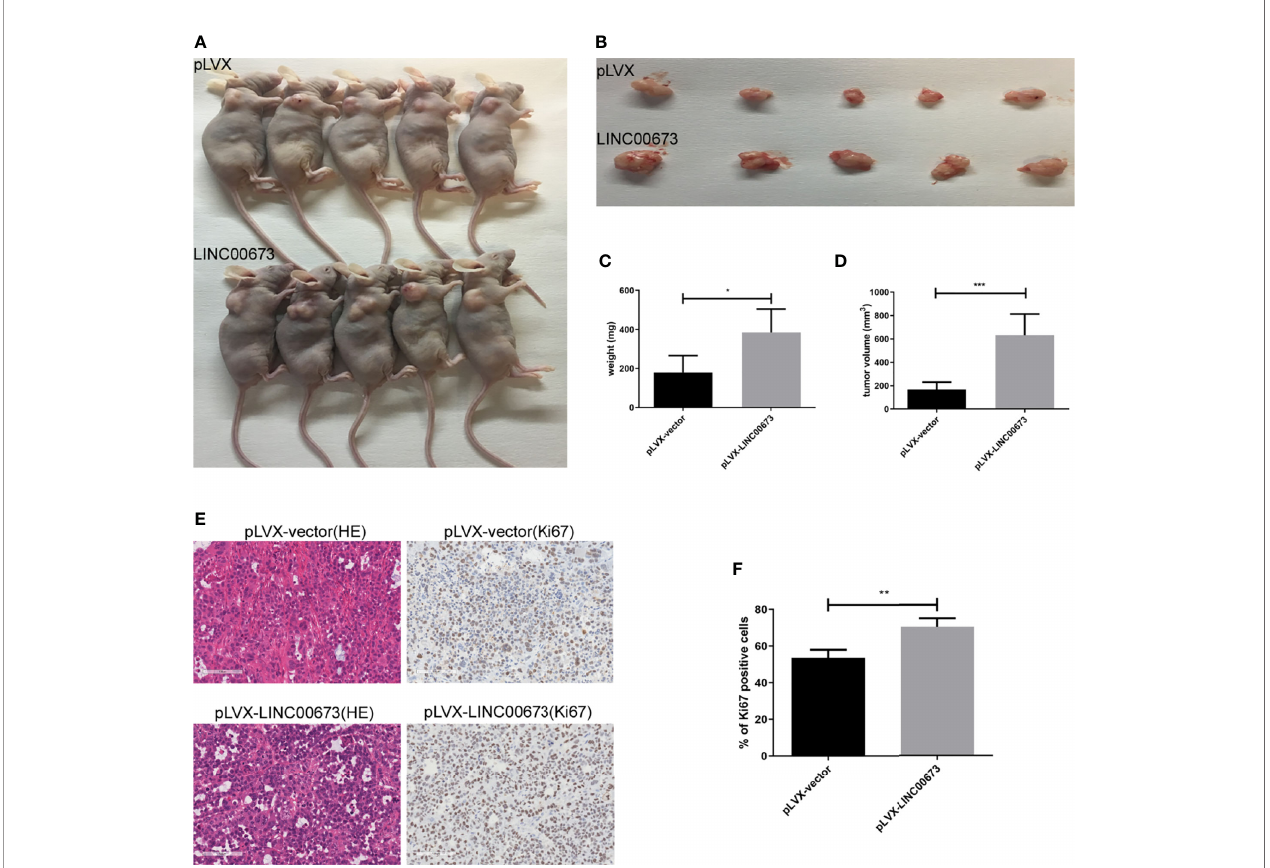
FIGURE 3 | LINC00673 promotes HeLa cell growth in vivo . (A) HeLa cells overexpressing LINC00673 and control cells were injected into nude mice as described in Methods. Xenograft tumor growth was monitored. (B – D) The xenograft tumors were dissected and weighed. (E) HE and Ki67 immunohistochemical stained sections from the xenograft tumors. (F) The percentages of Ki67 positive cells are indicated. Data are presented as mean ± SD (N = 5); * P < 0.05, ** P < 0.01, *** P < 0.001. Student ’ s t